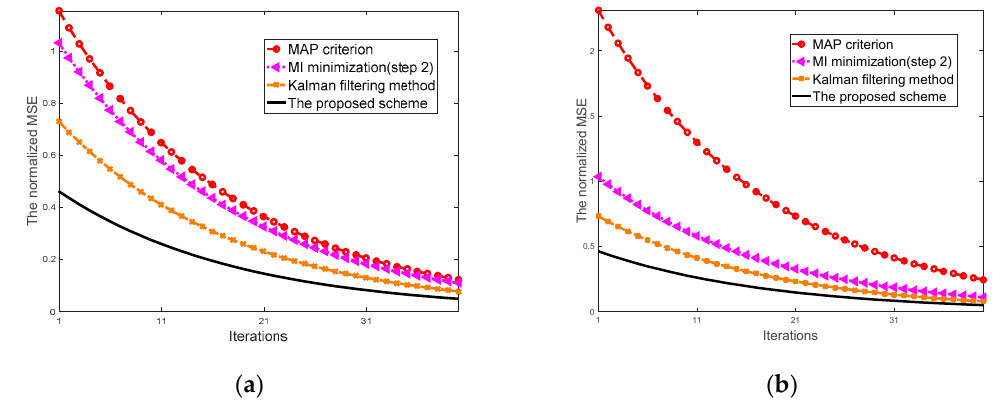
Figure 5. ( a ) The mean-square error (MSE) of target response estimation subject to power constraint; ( b ) the MSE of target response estimation subject to power and probability constraint.